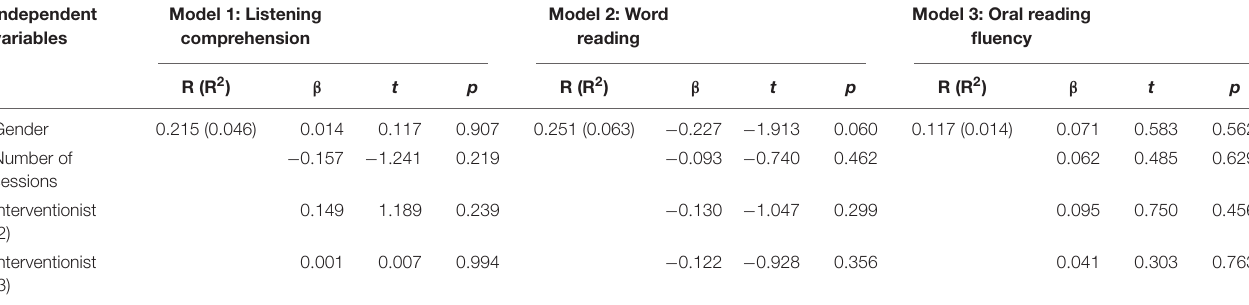
TABLE 2 | Results of the regression models to predict standardized gains in listening comprehension, word reading, and oral reading fluency. Independent Model 1: Listening variables comprehension